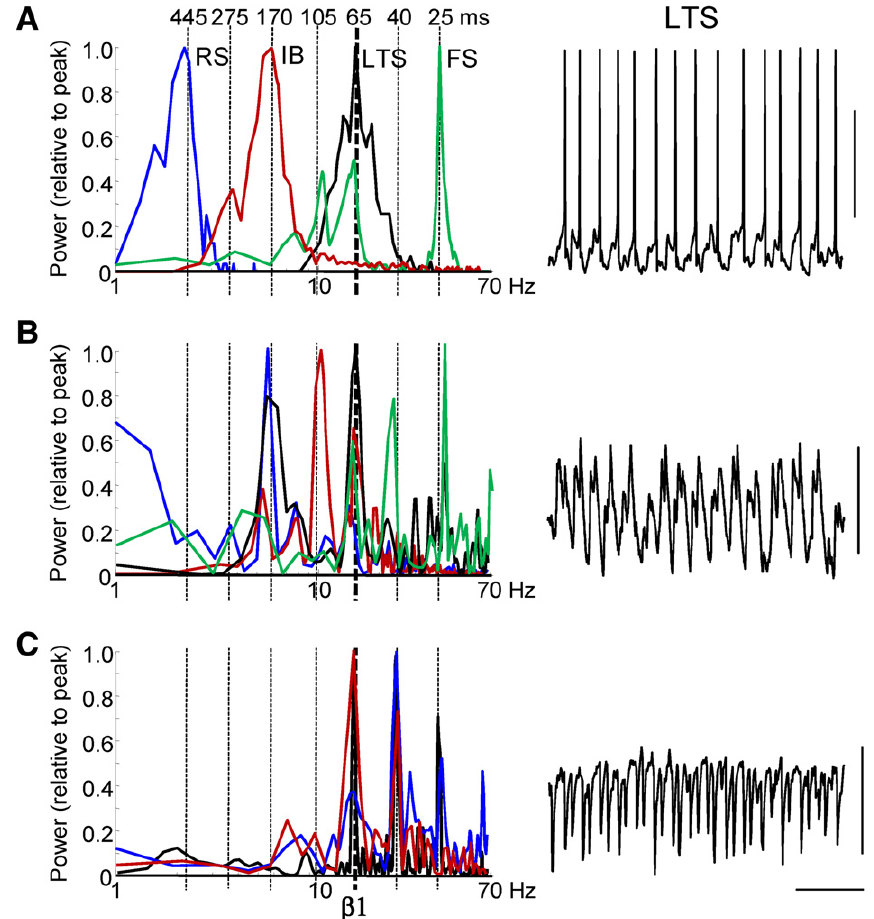
Figure 3. Multiple concatenation sums are evident in spike outputs and synaptic inputs in single neurons. (A) Frequency distribution of intracellularly recorded action potential generation from resting membrane potential (1/interspike interval, n = 500 spikes) during population beta1 rhythm for LII regular spik- ing cells (RS, blue), LII fast spiking cells (FS, green), LIII low threshold spiking cells (LTS, black) and LV intrinsic bursting cells (IB, red). Vertical dashed lines show successive concatenation sums from the original observed frequencies: gamma (25 ms) and beta2 (40 ms). Example trace shows 1 s epoch of activity from a LIII LTS cell illustrating action potential generation (truncated at − 20 mV) at beta1 frequencies. (B) Frequency distribution of excitatory postsynaptic potential (EPSP) inputs to each of the 4 cell types, taken from power spectra ( n = 5, 10 s epochs for each cell type) with mean membrane potential held at − 70 mV. Example trace is 1 s epoch of EPSP data from an LTS cell. Note the beta1 frequency compound EPSP trains consisting of doublets. (C) Frequency distribution of inhibitory postsynaptic potential (IPSP) inputs to each of the 4 cell types, taken from power spectra ( n = 5, 2 s epochs for each cell type) with mean membrane potential held at − 30 mV. Example trace is 1 s epoch of IPSP data from an LTS cell. Scale bars 20 mV (A) , 2 mV (B) , 10 mV (C) and 200